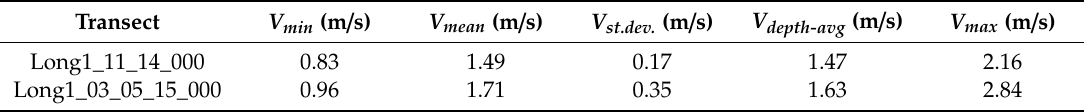
Table 4. Depth-averaged velocity in the ADCP transects collected in FS − CNS1 and FS − CNS2. Legend: V min = minimum depth-averaged velocity; V mean = mean of the depth-averaged velocity; V st.dev. = standard deviation of the depth-averaged velocity; V depth-avg = median of the depth-averaged velocity; V max = maximum depth-averaged velocity.